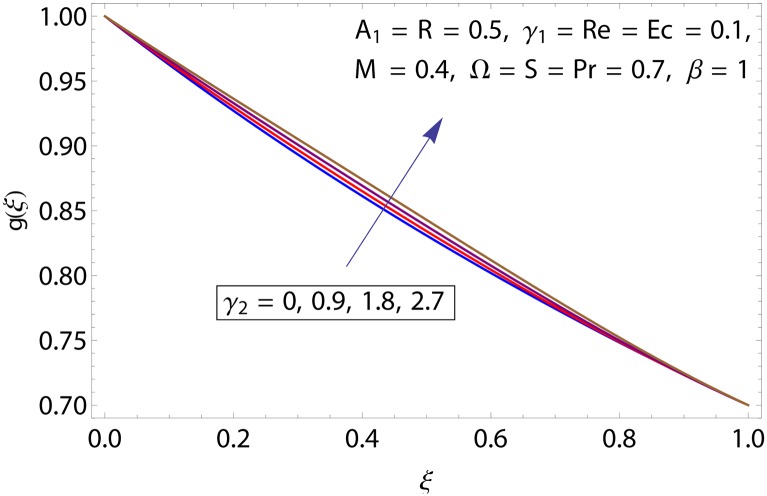
Impact of γ2 on g(ξ).